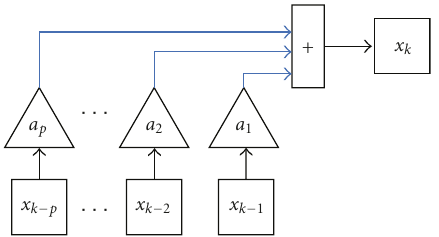
Figure 1: Schematic map for forward prediction filter.